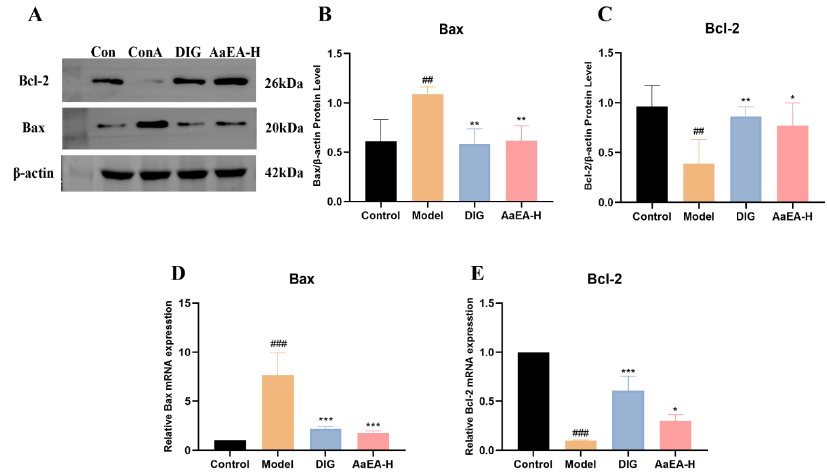
Figure 10. Effects of AaEA-H on Bax and Bcl-2 ( A ). Statistical analysis of Bax and Bcl-2 protein and mRNA relative expressions ( B – E ) (n = 3). Unless indicated, no significant difference was observed between groups. Compared with control group, ## p < 0.01 and ### p < 0.001. Compared with ConA group, * p < 0.05, ** p < 0.01, and *** p <